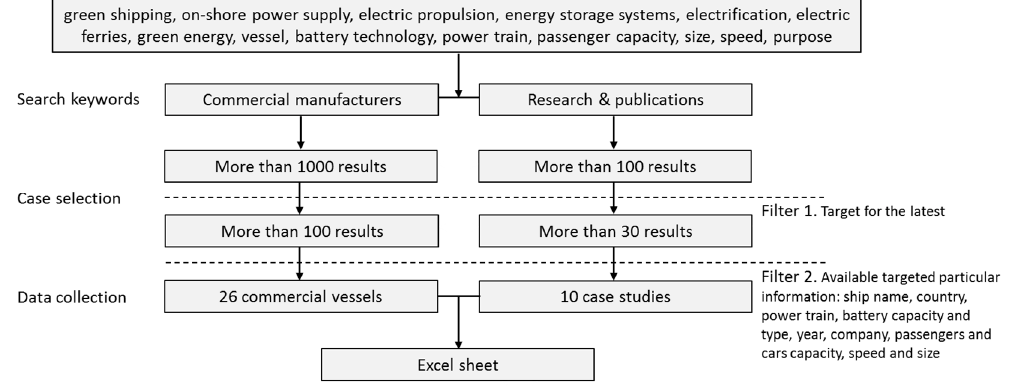
Figure 3. Details of conduct research step in the research framework model.